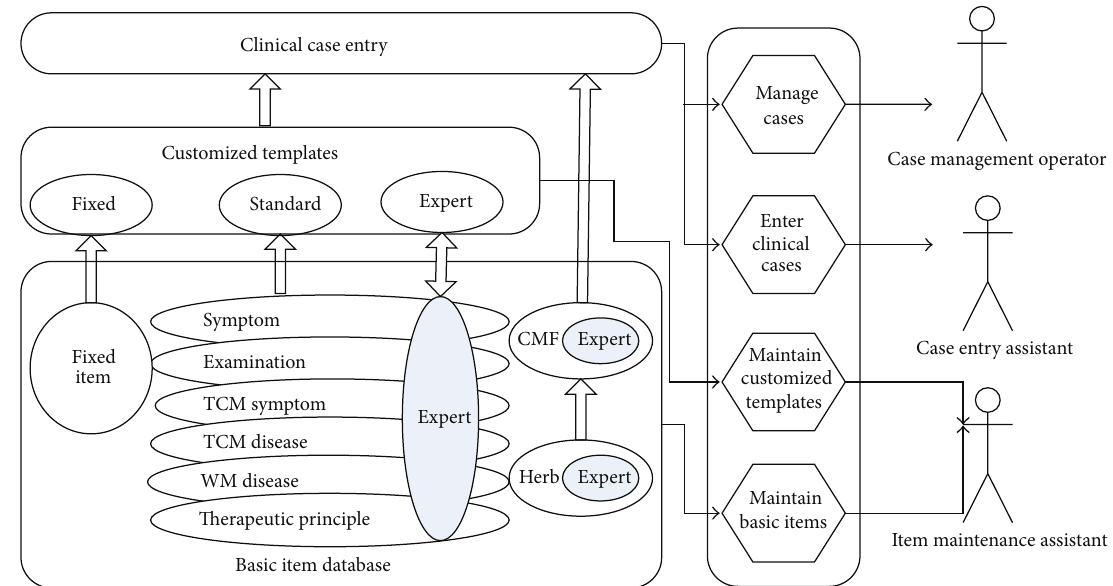
Figure 3: Overall design of the customized management of clinical